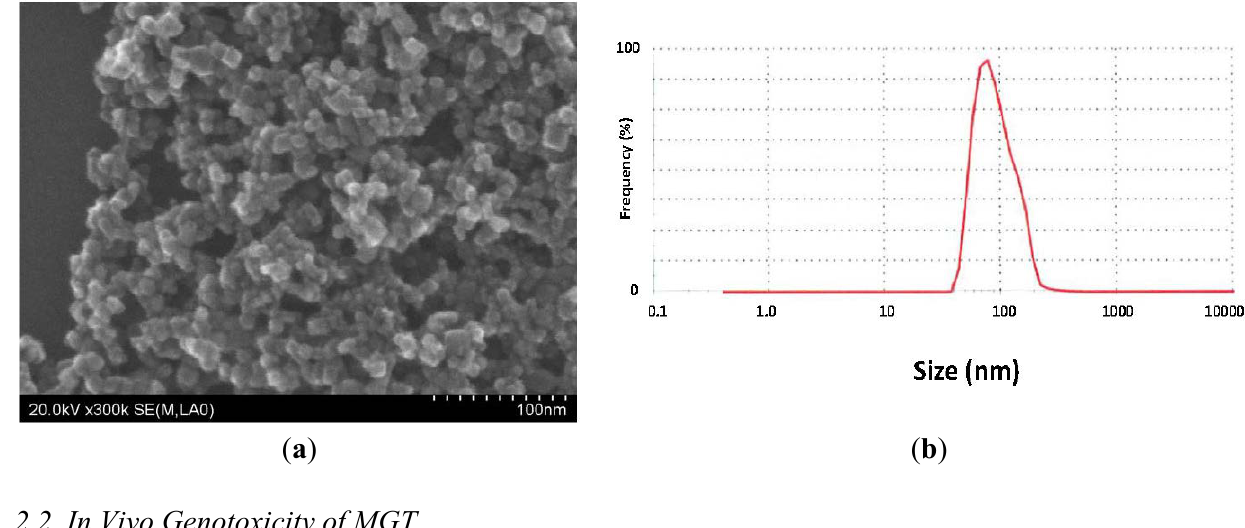
Figure 1. Crystal appearance and zeta potential of magnetite nanoparticles (MGT): ( a ) Scanning electron microscopy (SEM) micrographs of MGT obtained at E = 20 kV, ×300,000; and ( b ) Size distribution of MGT measured in water, 0.2 μ